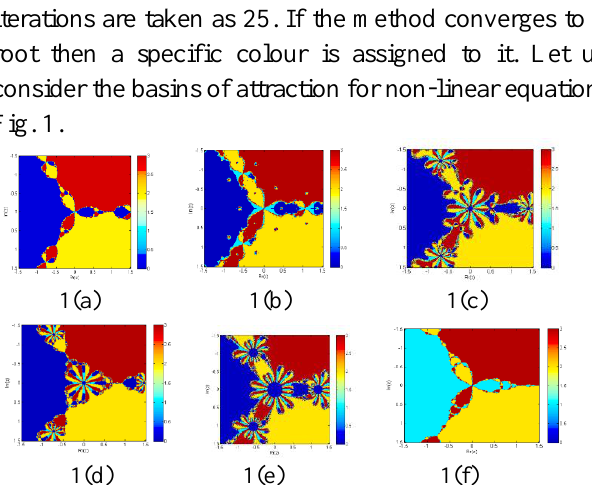
Fig. 1. (a-f), shows the basins of attraction of methods MS1- MS3, KM, CM and JM respectively for non-linear function colour shows less number of iteration for approximating